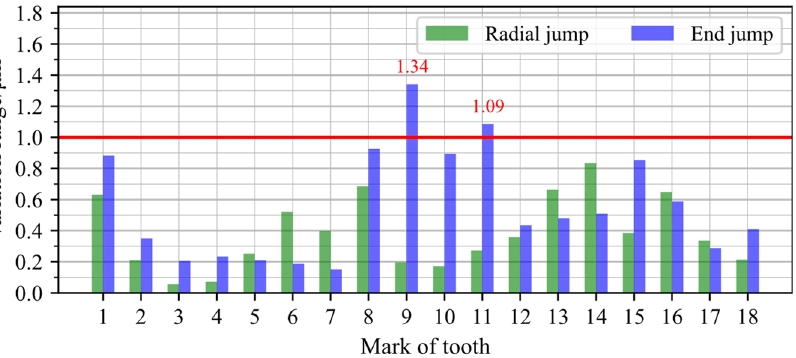
Figure 14. Statistical chart of the three test results of experimental group 1 after turning teeth.